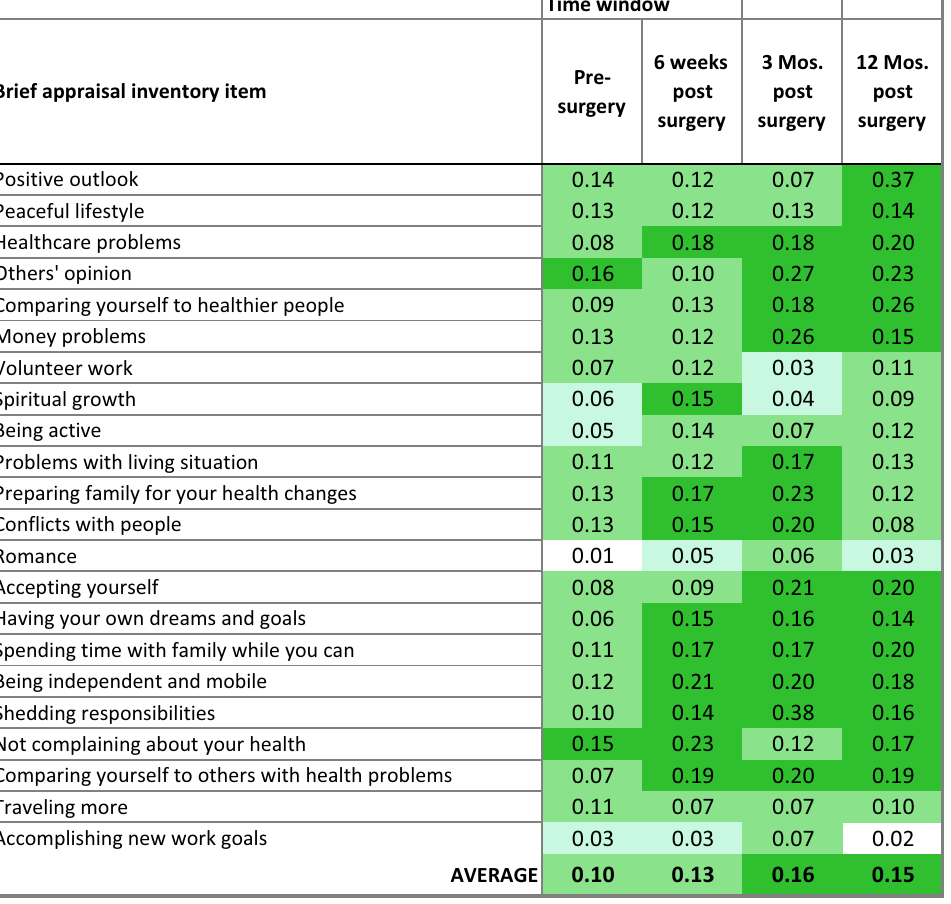
Time window Pre-